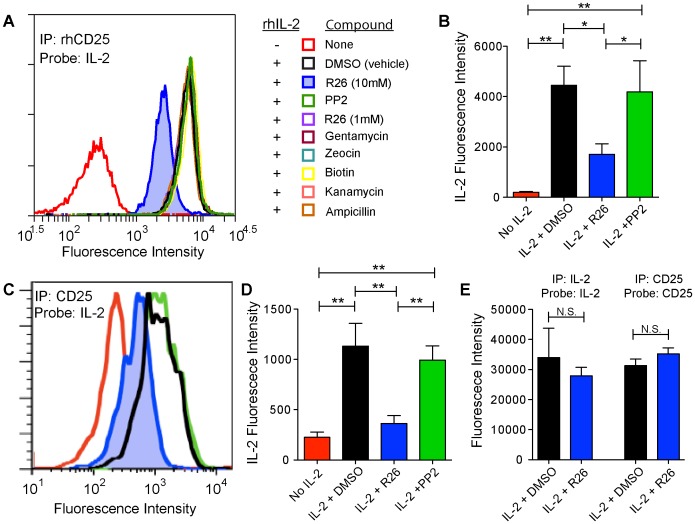
IP-FCM detects the specific inhibition of CD25:IL-2 interaction by the first-generation SMIPPI, Ro-26-4550.(A) Recombinant human CD25 (rhCD25) was immunoprecipitated with anti-CD25 antibody-conjugated CML beads. Recombinant human IL-2 (1000 U/ml) and one of several small-molecules were mixed with the beads for one hour, followed by probing with an anti-IL-2 antibody. Inhibition of the IL2:CD25 interaction was observed only upon addition of 10 mM R0-26-4550 (R26, blue shaded histogram). (B) Median fluorescence intensity from three experiments shows R26 significantly reduced IL-2:CD25 binding compared to either vehicle (DMSO) or PP2 negative controls (ANOVA: F3,10 = 10.82, p = 0.0051; **p<0.01, *p,0.05) (C) Endogenous CD25 was immunoprecipitated from lysates from PMA/Ionomycin-stimulated human PBMCs, and analyzed as in (A) using 10,000 U/ml IL-2. (D) Median fluorescence intensity from four experiments including (C) shows R26 significantly reduced IL-2:CD25 binding compared to either vehicle (DMSO) or PP2 negative controls (ANOVA: F3,15 = 10.07, p = 0.0013; **p<0.01) (E) Experiments for (C–D) included IL-2 and CD25 ELISAs that were performed. Compared to negative controls, R26 did not change the amount of IL2 or CD25 detected (N.S, not significant by Student’s T-test, p>>0.05), indicating that the difference in (C–D) was due altered IL-2:CD25 interaction.